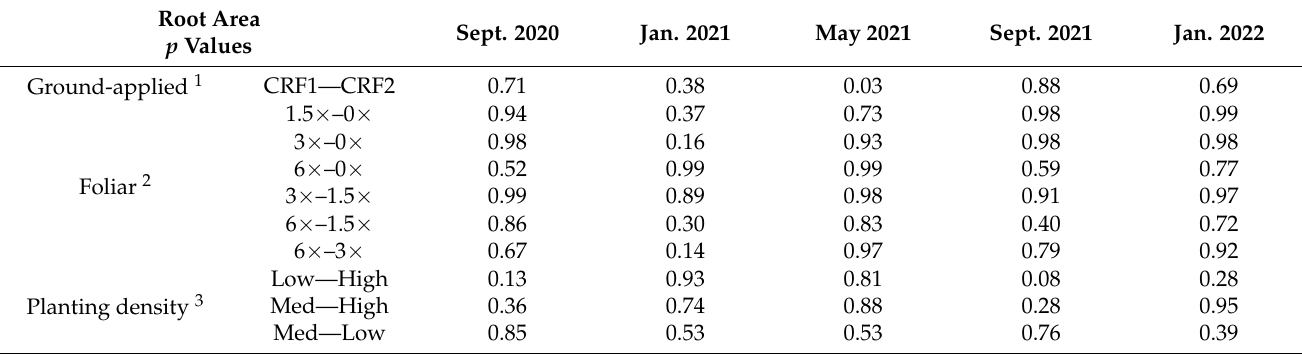
Table 9. p -values obtained via a three-way ANOVA followed by Tukey’s post hoc test, corresponding to the total root area of ‘Ray Ruby’ grapefruit grafted on ‘Kuharske’ citrange planted in flatwood soils located in Fort Pierce, FL, USA, and treated with ground-applied fertilizer, foliar fertilizer and different planting densities from September 2020 to January 2022. Bold values were considered to be significantly different ( p < 0.05).